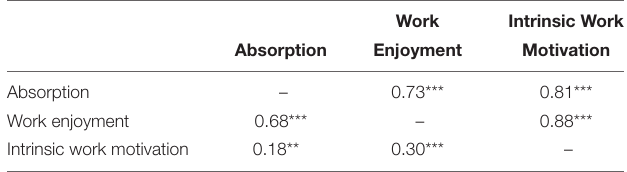
ICM-CFA correlations are displayed above the diagonal and ESEM correlations are displayed below the diagonal. **p < 0.01; ***p < 0.001.